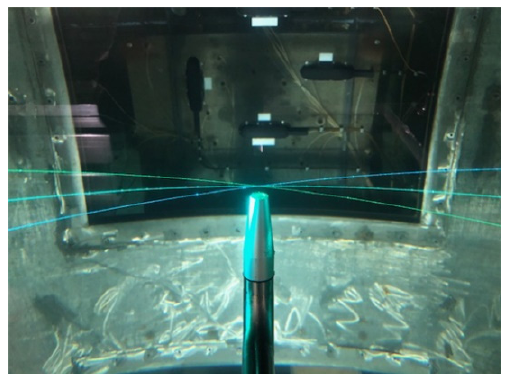
Figure 9. Photo of laser beams and water injection nozzle (top view).